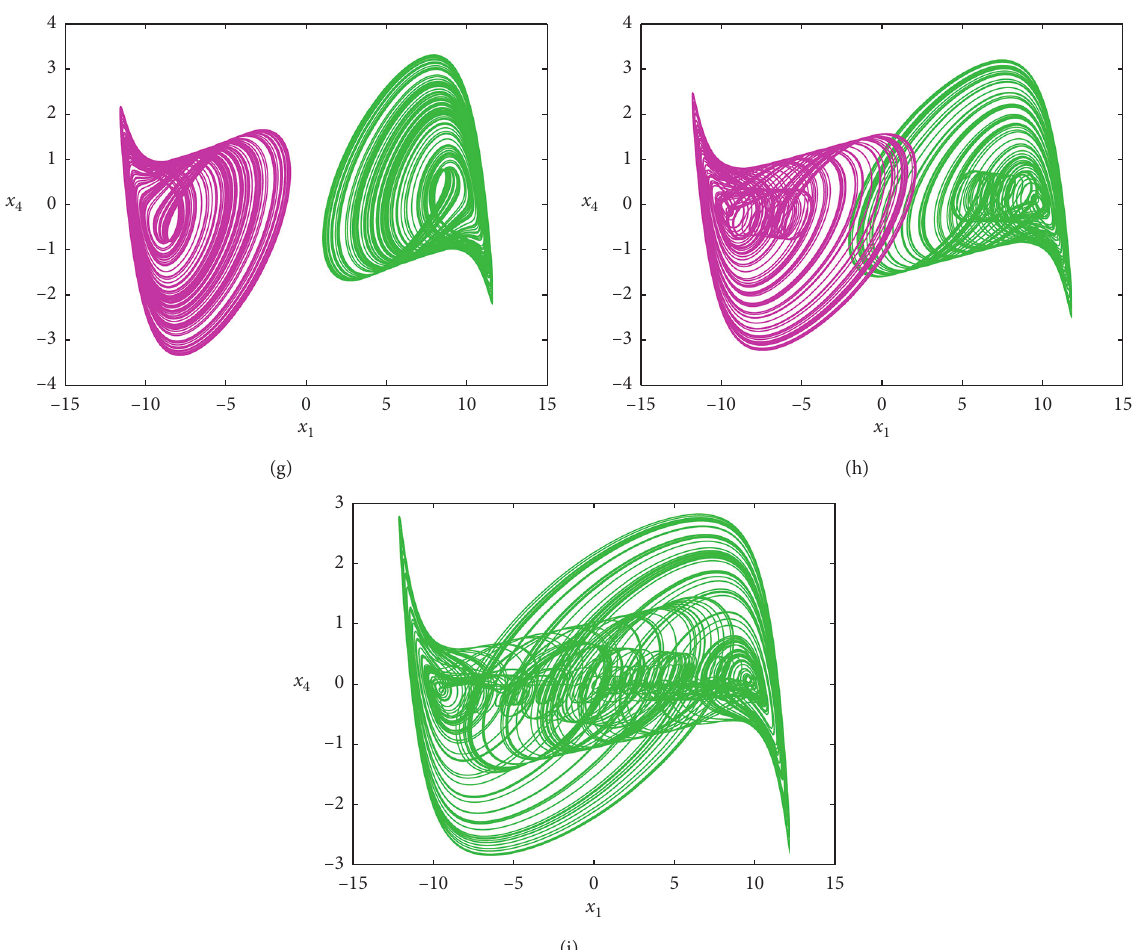
Figure 4: Numerical phase space trajectories showing routes to chaos in the system when varying the control parameter c : (a) period-1 for a � 7, (b) period-2 for a � 12 . 38, (c) period-4 for a � 13, (d) period-8 for a � 13 . 49, (e) single-band chaos for a � 14 . 6, (f) period-5 for a � 16 . 08, (g) single -band chaos for a � 16 . 7, (h) single-band chaos for a � 20, and (h) double-band chaos for a � 30. Initial conditions (